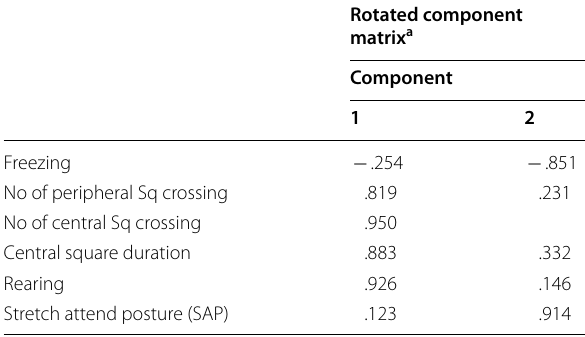
Table 3 Rotated component matrix of factor analysis (Varimax